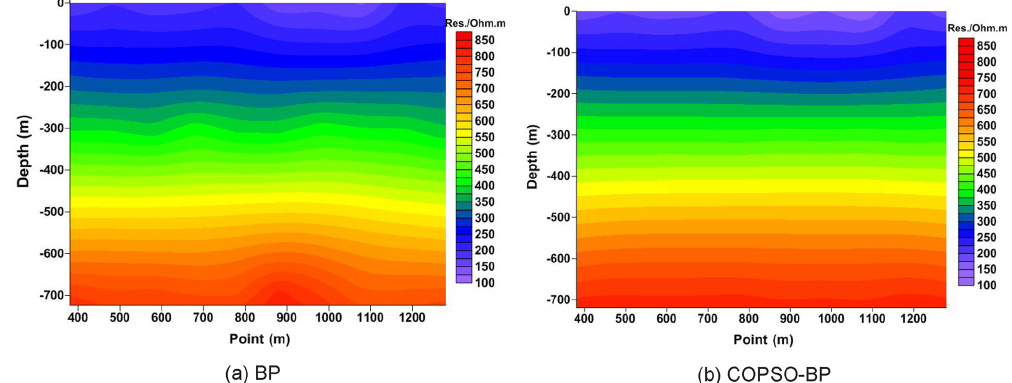
Figure 14. Inversion results for BP (a) and COPSO-BP (b) .